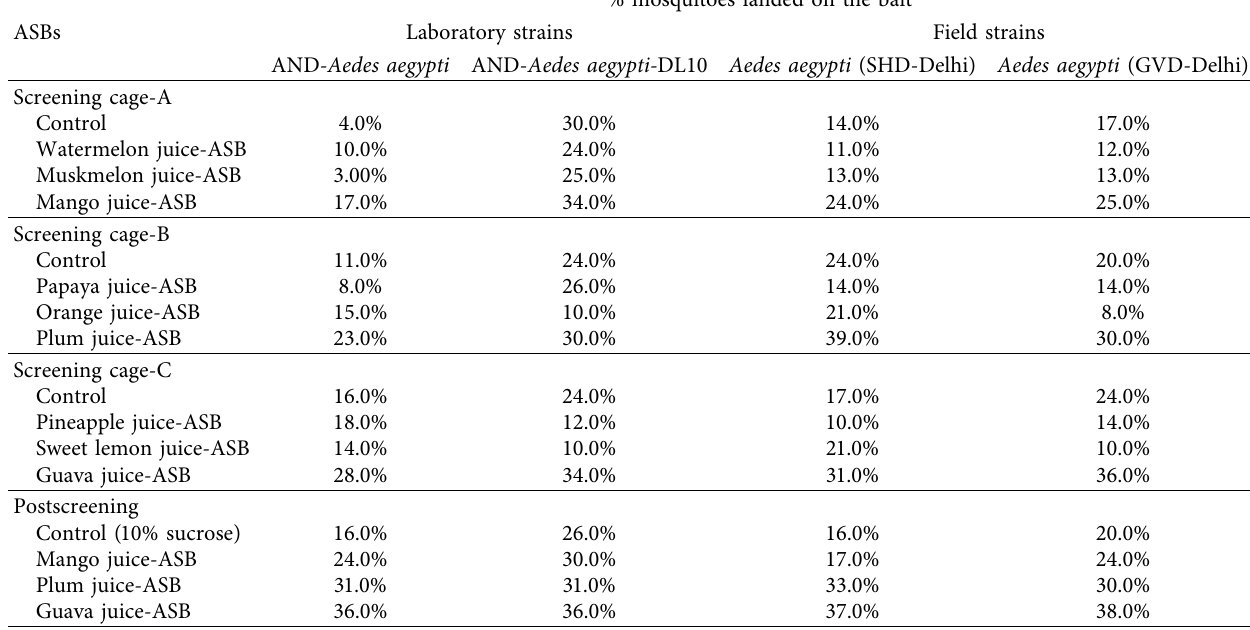
Table 2: Percentage of laboratory and field strain mosquitoes attracted towards different ASBs in screening and postscreening assays.